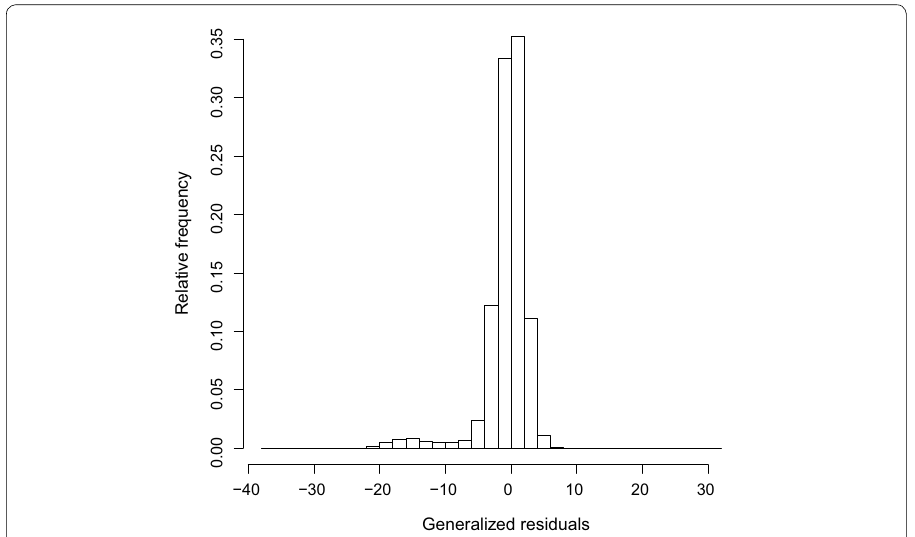
Fig. 7 Generalized residuals for 2nd order marginals for the 2009 science grade 12 data